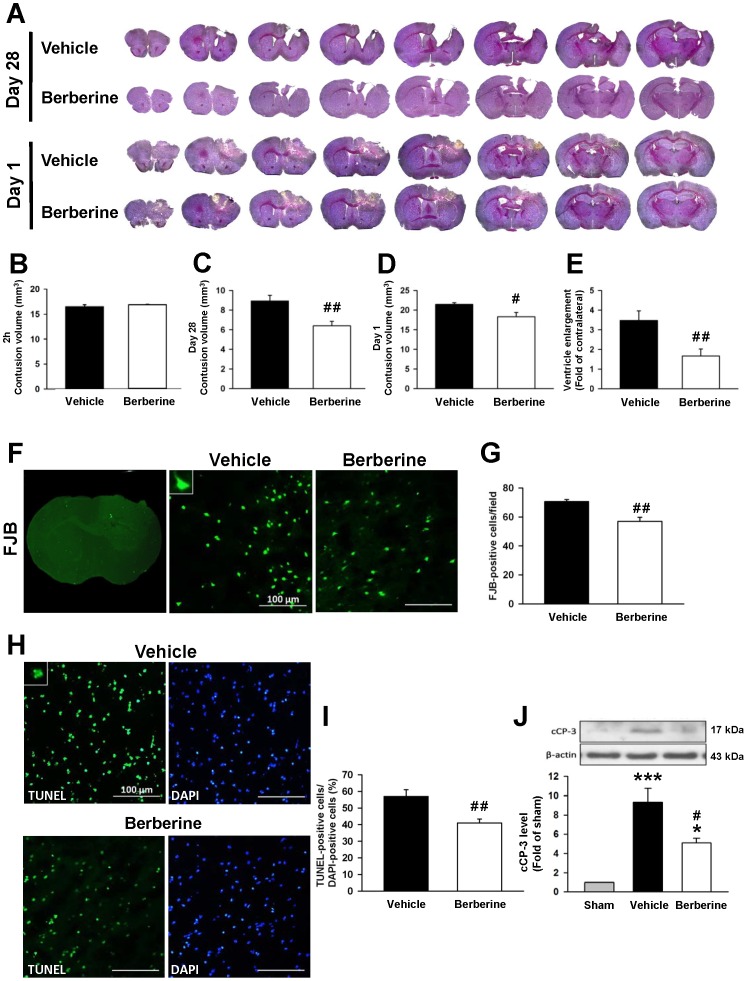
Post-injury berberine treatment attenuated contusion volume, neuronal death and apoptosis after TBI.(A) Representative cresyl violet-stained brain sections from vehicle- and 10 mg·kg−1 berberine-treated mice at 1 and 28 days post-TBI illustrating hypointense regions immediately below the impact site in the cortex. Quantitative analysis showed that berberine did not affect contusion volumes at (B) 2 h but significantly reduced contusion volumes compared with vehicle-treated mice at both (C) 28 and (D) 1 days post-TBI. (E) Lateral ventricular enlargement was significantly smaller in 10 mg·kg−1 berberine-treated mice than in vehicle-treated mice on day 1. (F) Representative Fluoro-Jade B (FJB)-stained coronal section of a core contusion region 0.74 mm from the bregma. The inset is a representative FJB-positive cell at higher magnification. (G) Quantitative analysis indicates that berberine-treated mice had significantly fewer degenerating neurons than vehicle-treated mice in the cortical contusion margin at 1 day post-TBI. The total number of FJB-positive cells is expressed as the mean number per field of view (0.8 mm2). Scale bar, 100 µm. (H) Representative terminal deoxynucleotidyl transferase-mediated dUTP-biotin nick end labeling (TUNEL, green)- and DAPI (blue)-stained brain sections of a 10 mg·kg−1 berberine- and vehicle-treated mouse at 1 day post-TBI. The inset is a representative TUNEL-positive cell at higher magnification. (I) Quantitative analysis shows that berberine-treated mice had significantly fewer TUNEL-positive cells than the vehicle-treated mice in the cortical contusion margin at 1 day post-TBI. The percentage of TUNEL-positive cells is expressed as the number of TUNEL-stained nuclei/the total number of DAPI-stained nuclei. Sections were stained with DAPI (blue) to show all nuclei. Scale bar, 100 µm. Values are mean ± SEM: #
P<0.05 and ##
P<0.01 vs. the vehicle group as determined by the Student's t-test (n = 6–8 mice/group for cresyl violet and n = 6 mice/group for FJB and TUNEL histochemistry). (J) Western blot analysis of cleaved caspase-3 (cCP-3) in the ipsilateral hemisphere of sham-injured, vehicle-treated, and 10 mg·kg−1 berberine-treated mice at 1 day post-TBI. Berberine significantly decreased the cCP-3 level. Values are mean ± SEM; *
P<0.05, ***
P<0.001 vs. the sham group; #
P<0.05 vs. the vehicle group as determined by one-way ANOVA (n = 6–8 mice/group for cCP-3 Western blot).